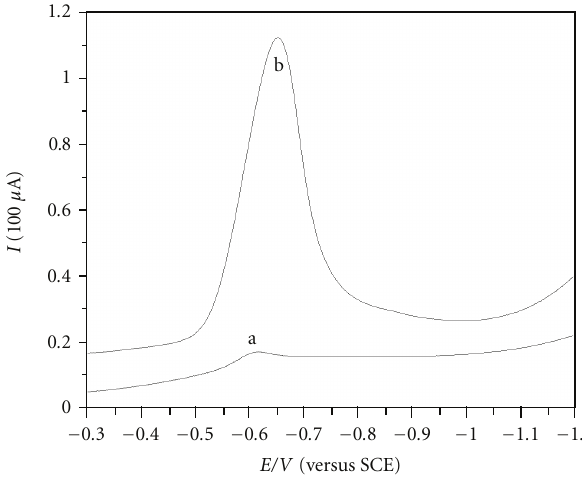
Figure 3: Cyclic voltammograms of 1.9 × 10 − 5 molL − 1 parathion in pH 6.0 PB solution at the poly(safranine) film-modified electrode. Scan rate: 100 mVs − 1 .